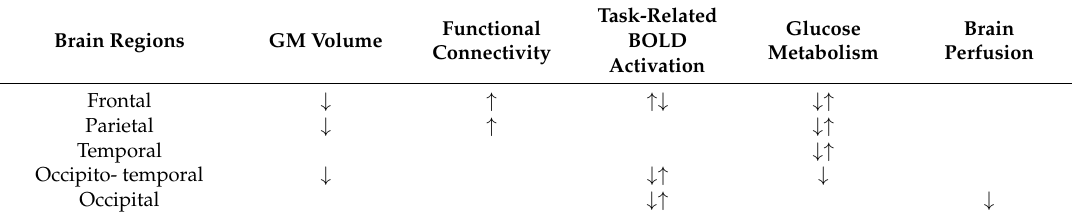
Table 1. Summary of the most consistent findings associated with VHs in